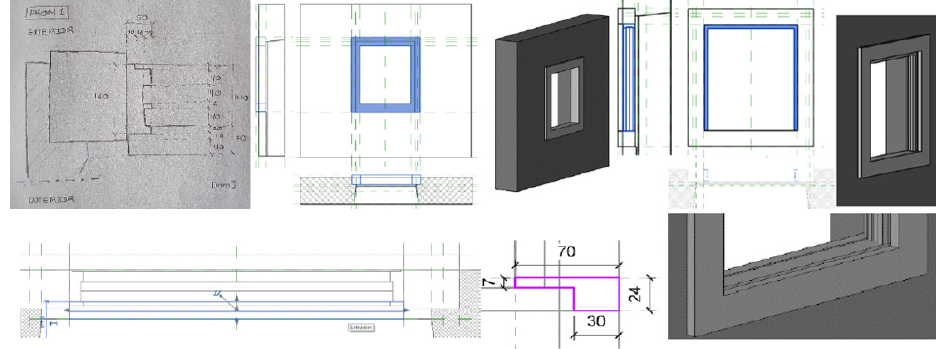
Figure 15. Modelling of surrounding stonework elements.